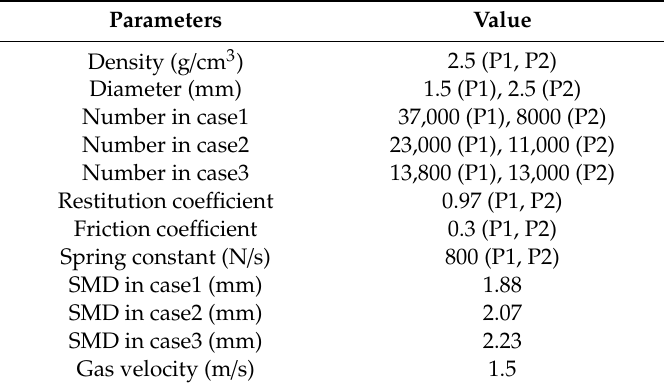
Table 3. Details of the gas-solid properties in the current simulation, P1 for the small particle and P2 for the large particle.